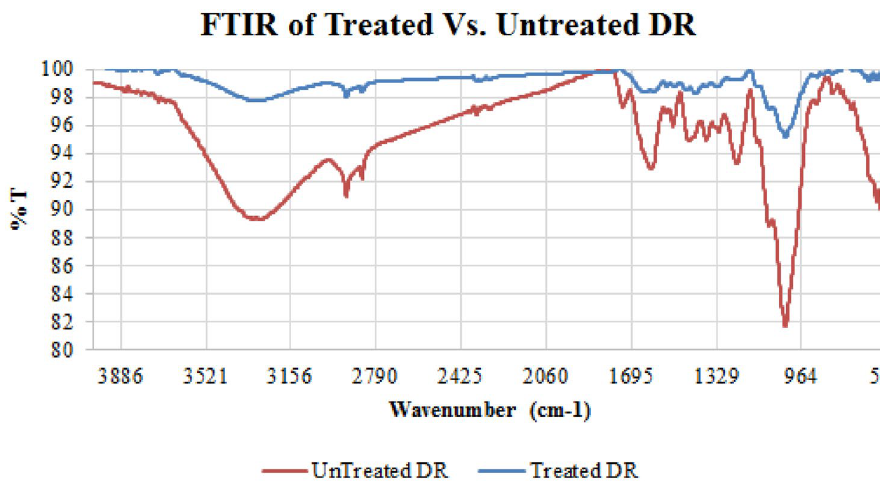
Fig. 5 FTIR spectrum of untreated and treated Delonix Regia